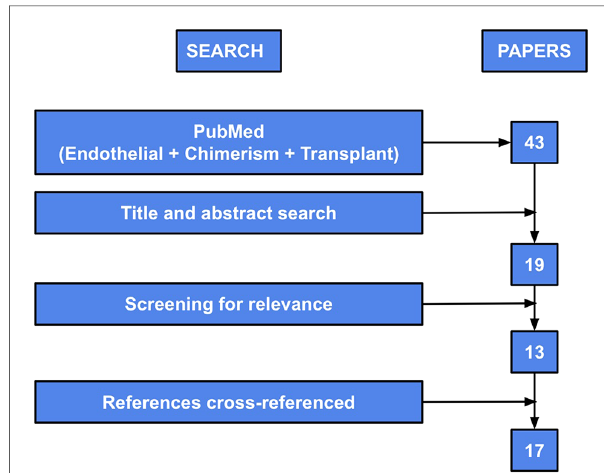
FIGURE 3 Diagram of search methods used to perform systematic review. “ PubMed ” refers to the initial keyword search within the PubMed database. “ Title and abstract search ” refers to review of titles and abstracts and exclusion per exclusion criteria noted above. “ Full article search ” refers to full paper review and exclusion at that point per exclusion criteria noted above. “ Screening for relevance ” refers to assessment of the publications ’ relevance to this review. “ References cross-referenced ” refers to review of the references from the original included papers and the addition of papers if they satis fi ed inclusion and exclusion criteria. Figure adapted from Bolado and Landin